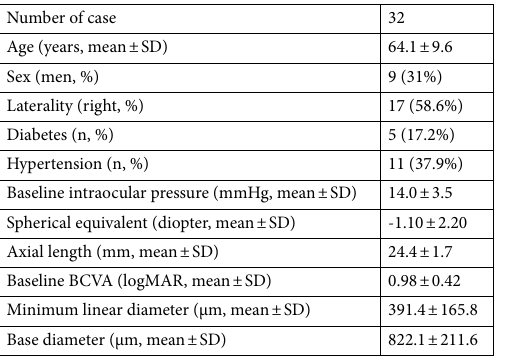
Table 1. Demographics. SD standard deviation, BCVA best-corrected visual